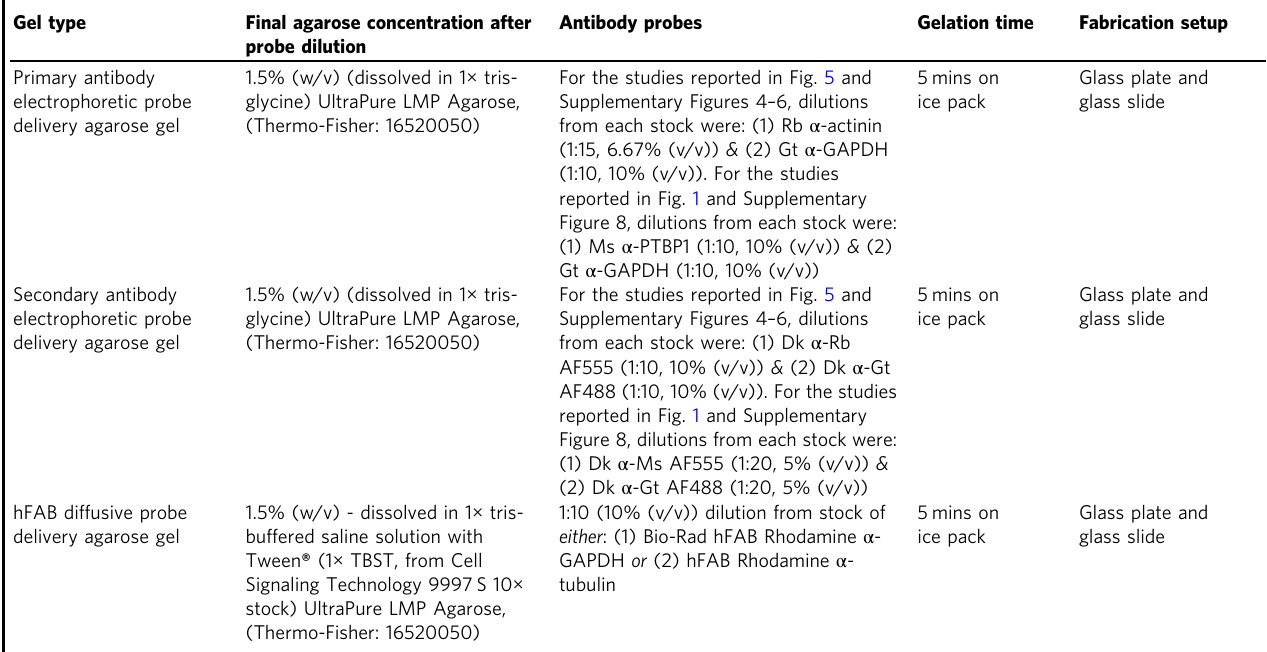
Table 2 Probe delivery gel fabrication parameters for electrophoretic and diffusive